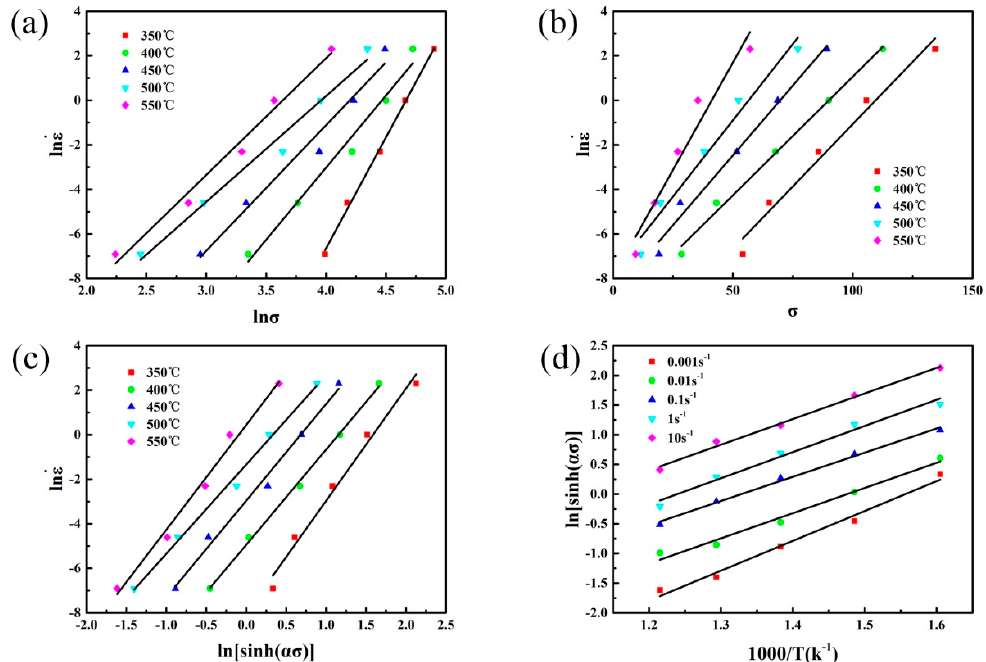
Figure 2. Relationship between ( a ) ln σ and ln ε(cid:4662) ; ( b ) σ and ln ε(cid:4662) ; ( c ) ln[sinh(ασ)] and lnε(cid:4662) ; ( d ) 1000/T and ln[sinh(ασ)] .